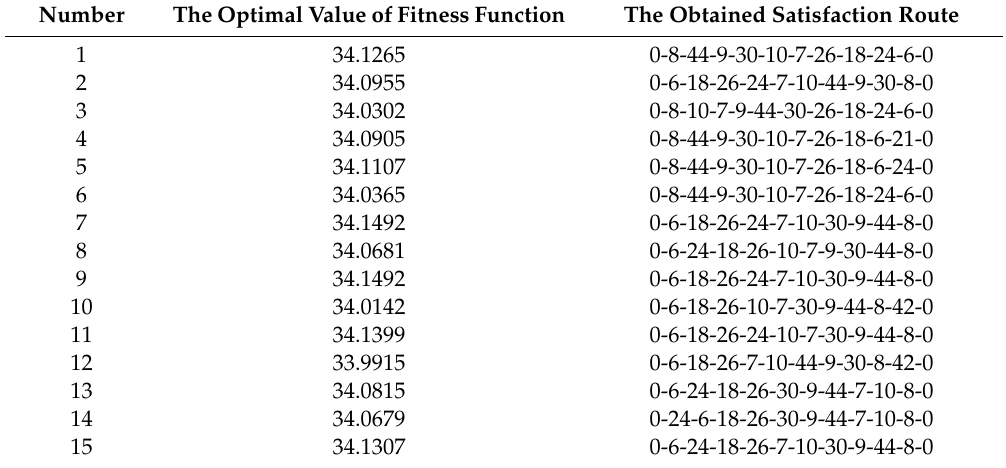
Table 11. The results of 15 tests using the APGA (60 attractions)